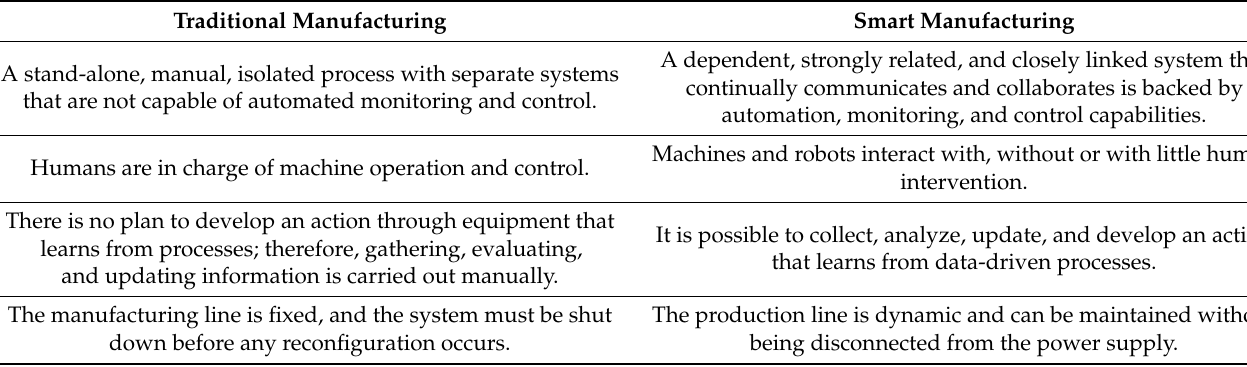
Table 4. Differences between traditional manufacturing and smart